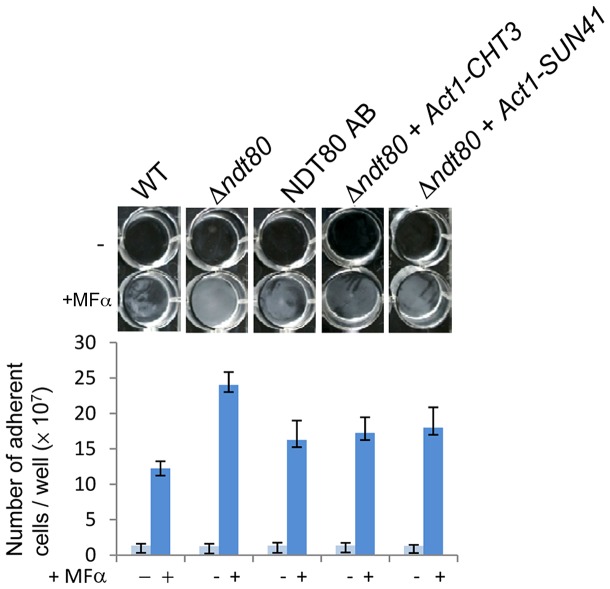
Role of NDT80 in formation of pheromone-stimulated biofilms.White cells lacking NDT80 formed hyper-biofilms that contained increased numbers of adherent cells and were difficult to remove from the plate. Overexpression of cell wall degrading genes, CHT3 or SUN41, decreased hyper-biofilm formation in the ndt80 background. Each data point is the mean ± SD from two independent experiments with at least three replicates. “*” represents P<0.001 for WT v. Δndt80. “#” represents P<0.05 for Δndt80 v. Δndt80 AB, Δndt80 v. Δndt80+Act1-CHT3, and Δndt80 v. Δndt80+Act1-SUN41. (WT: RBY717; Δndt80: RBY520; NDT80 AB: CAY3593; Δndt80-Act1-CHT3: CAY3818; Δndt80-Act1-SUN41: CAY3816).